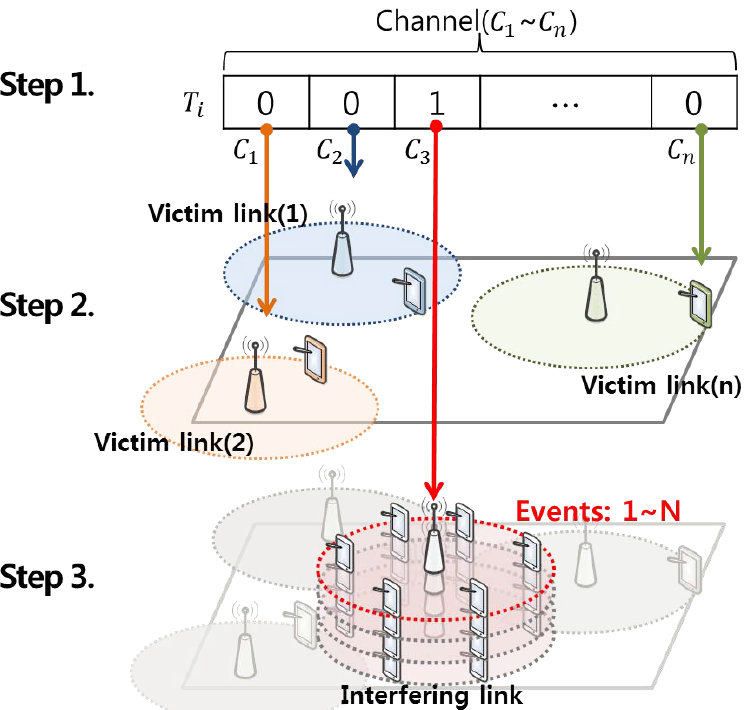
Figure 9. Simulation environment created by the space–time and frequency domains.